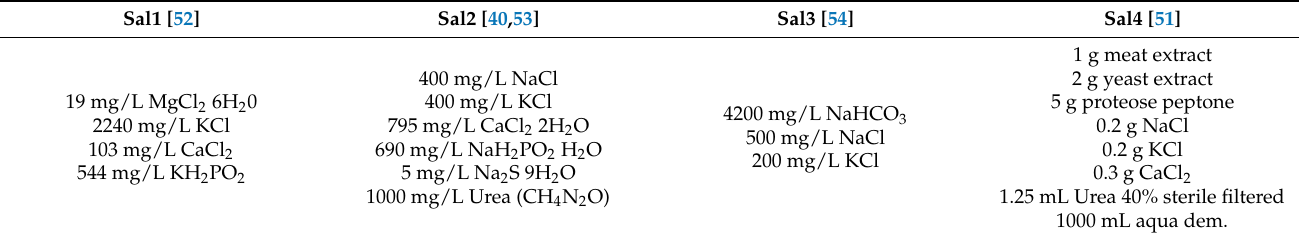
Table 1. Composition of the four different artificial saliva replacement